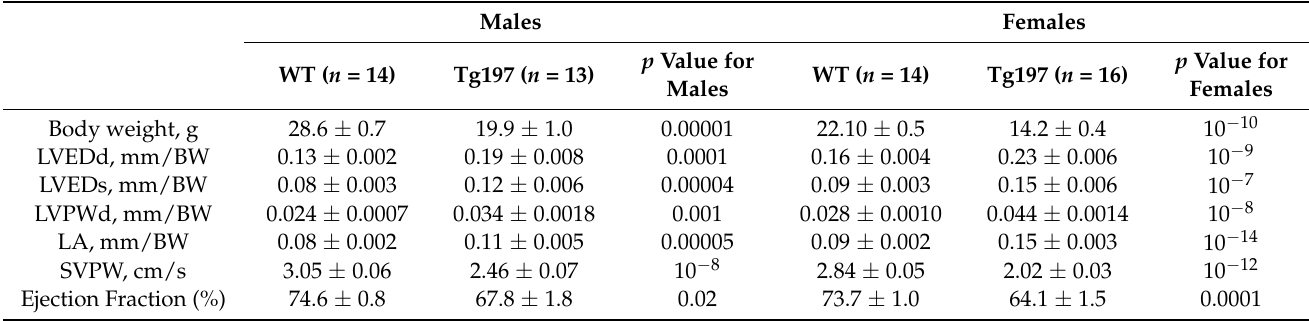
Table 1. Echocardiographic analysis in male and female Tg197 and WT